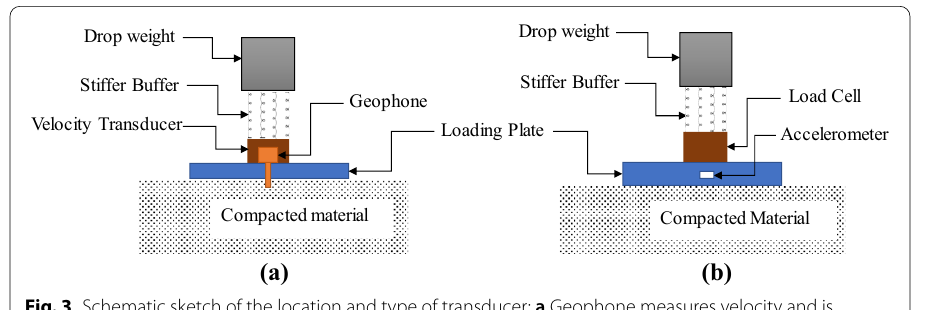
Fig. 3 Schematic sketch of the location and type of transducer: a Geophone measures velocity and is located on the compacted material, b Accelerometer measures vibrations and is located in the plate